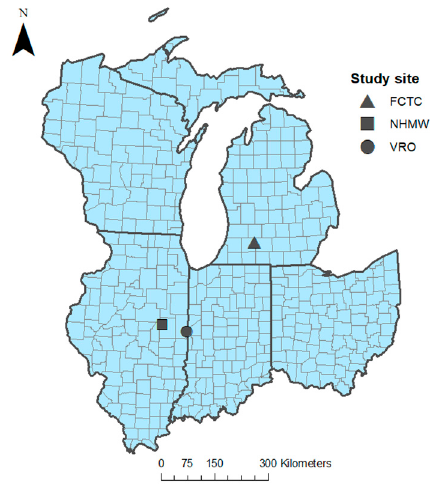
Figure 2. Study sites at Fort Custer Training Center (FCTC), Michigan, and Nettie Hart Memorial Woods (NHMW) and Vermilion River Observatory (VRO), Illinois, USA.